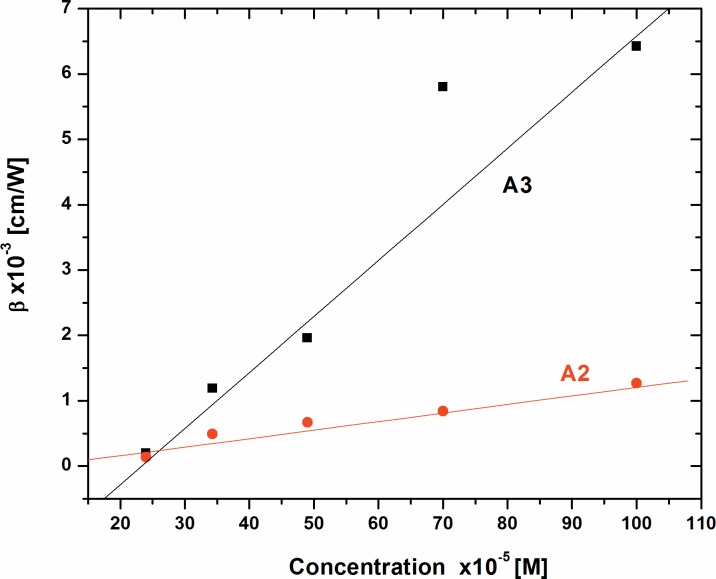
Variation of nonlinear absorption of Dyes A2 and A3 as a function of concentration.